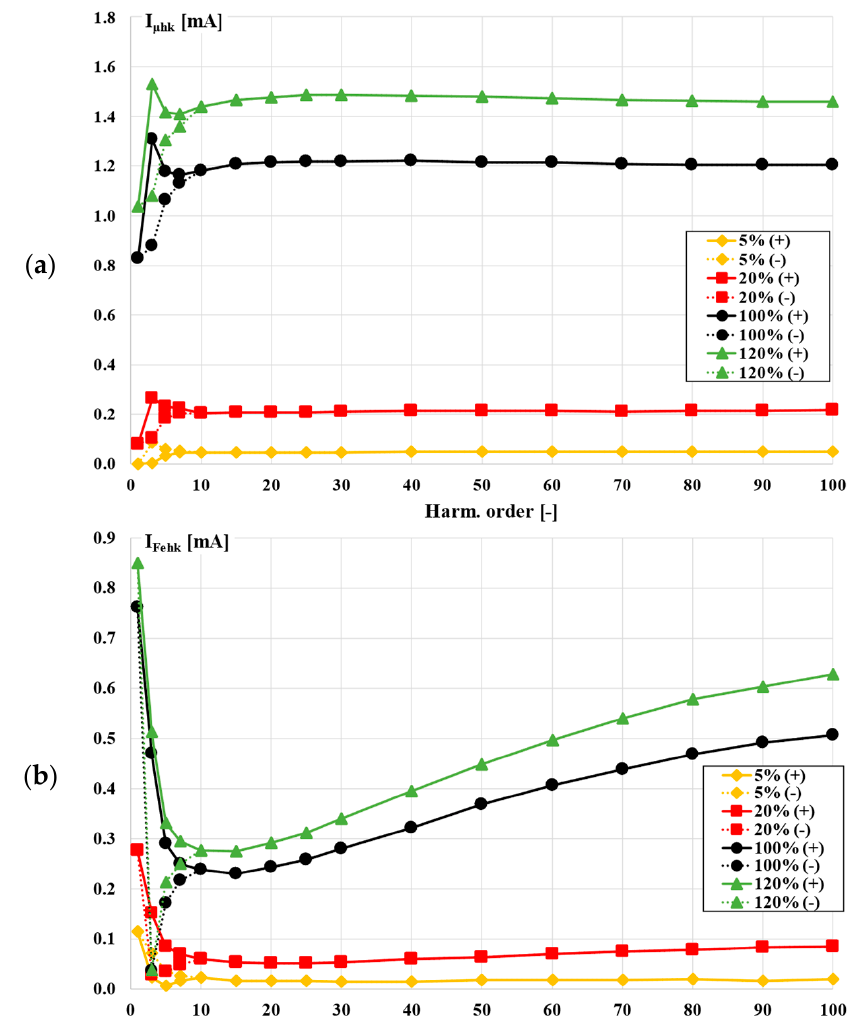
Figure 9. The change of the values of the core excitation current components of the tested CT ( a ) reactive and ( b )